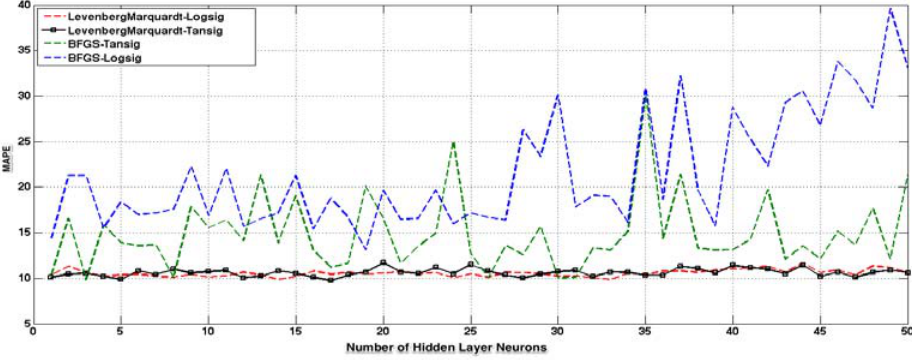
Fig. 9. Number of hidden layer neurons and transfer functions price forecast results